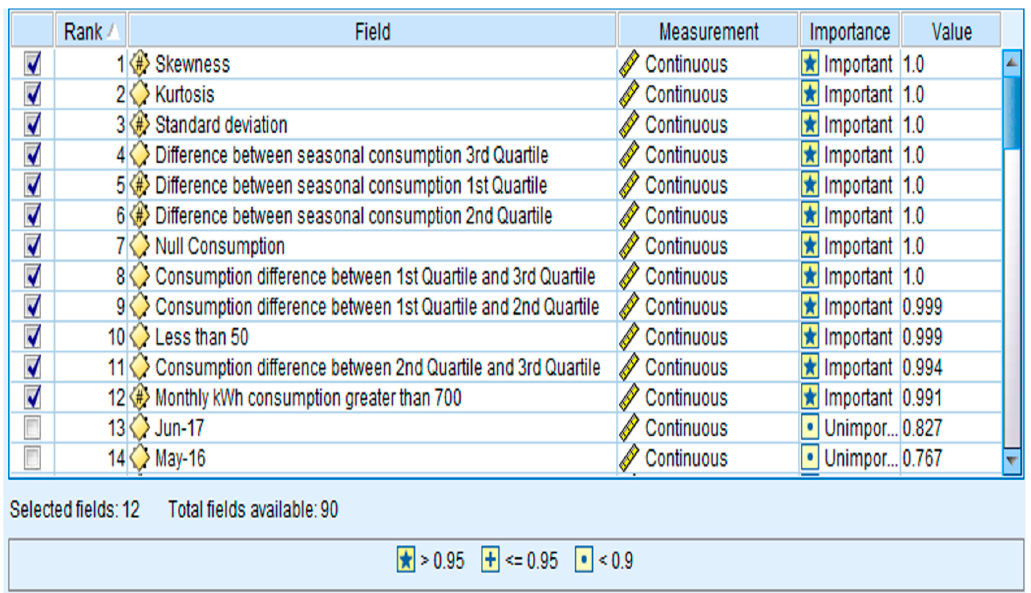
Figure 2. Top twelve selected features for model training.